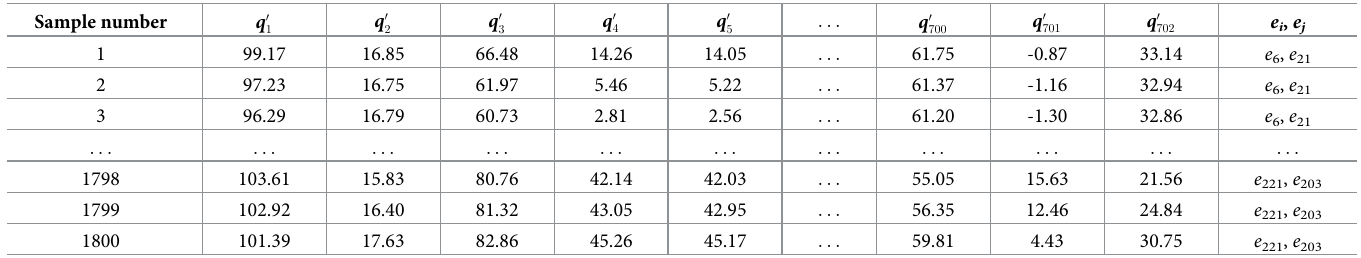
Table 2. Fault sample